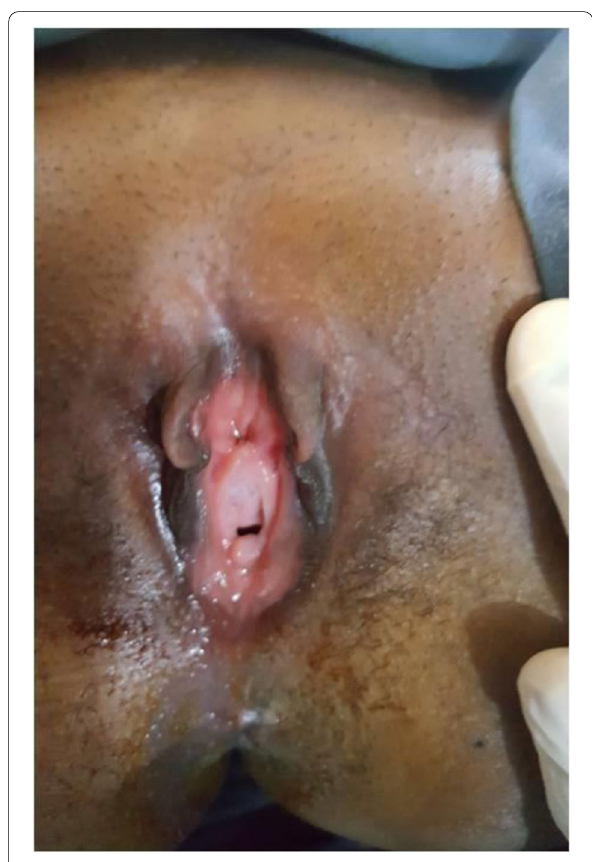
Fig. 1 Clinical photograph showing the depressed mons, bifid clitoris, underdeveloped labia, patulous urethral opening, and normal vagina